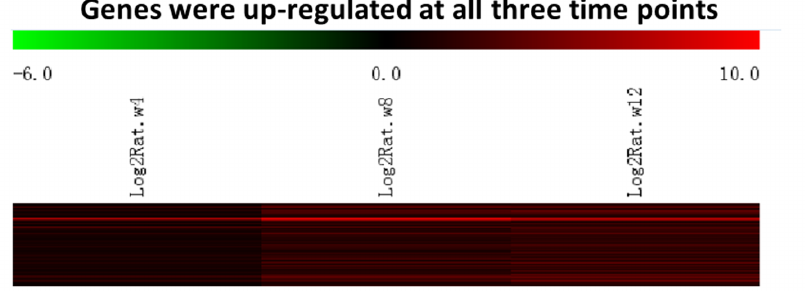
Figure 3. The Heat Map and the list of genes which were up-regulated at all three time points (4, 8, 12 weeks of age). There were a total of 69 genes in the list. doi:10.1371/journal.pone.0093019.g003 beta signaling and fibrosis (Tables S7 in File S2, Tables S17, and